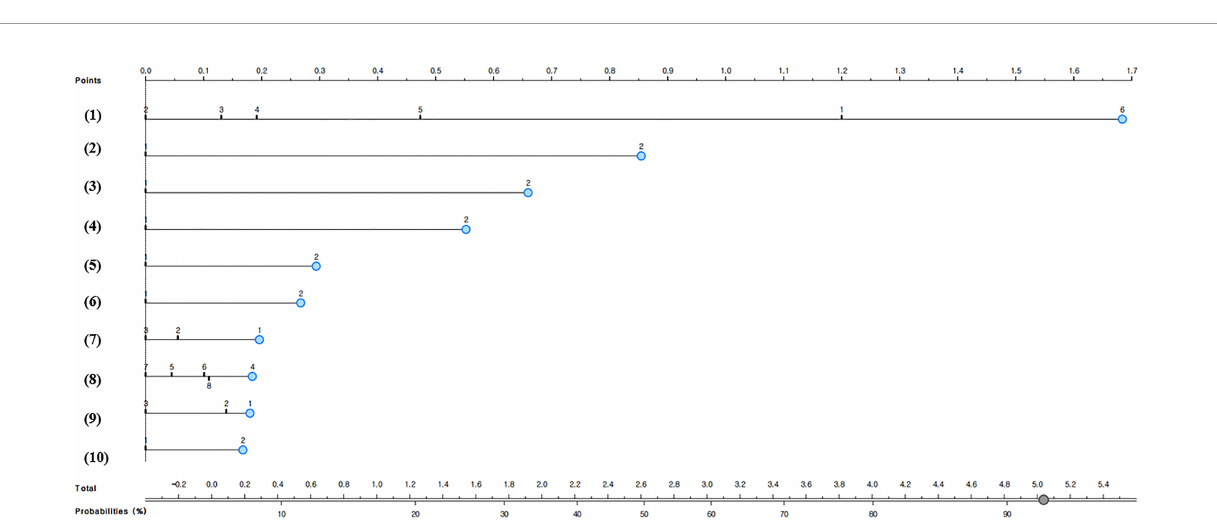
FIGURE 2 | Nomogram for predicting the non-utilization of microprotein urination test in South Korean diabetic patients; (1) Number of glycated hemoglobin tests in the past year: 1 = don ’ t know what glycated hemoglobin is, 2 = 4 times or more, 3 = 3 times, 4 = 2 times, 5 = 1 time, or 6 = not measured, (2) Insulin treatment: 1=Yes or 2=No, (3) Oral diabetes medication: 1=Yes or 2=No, (4) Completion of diabetes management education: 1=Yes or 2=No, (5) Diabetes non-drug treatment: 1 = Yes or 2 = No, (6) Residential area: 1=Urban or 2=Rural, (7) Household composition: 1 = single-person household, 2 = two-person household, or 3 = household with three or more members, (8) Age: 4= ≤ 49 years old, 5 = 50-59 years old, 6 = 60-69 years old, 7 = 70-79 years old, or 8 = 80 years old or older, (9) Subjective health: 1 = good, 2 = moderate, or 3 = poor, and (10) Recognition of own blood glucose level: 1=Yes or